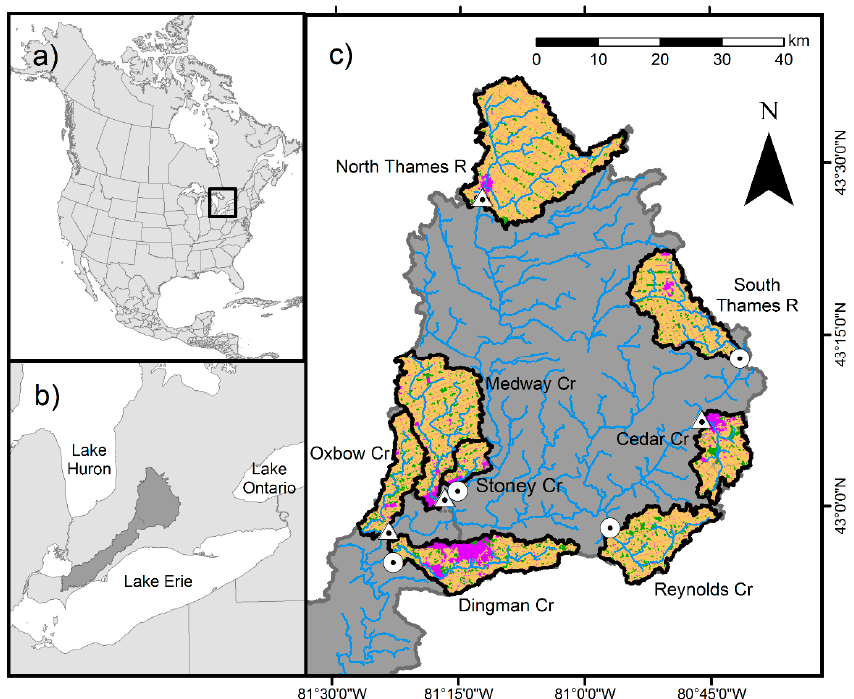
Figure 1. Position of study area in the Great Lakes region of North America ( a ) and location of Thames River watershed in southern Ontario ( b ). Location and land cover (agriculture [orange]; forest [green]; urban [purple]) of eight impacted streams and their associated catchments (black outlines) within the Upper Thames River Basin ( c ). Streams influenced by dams have site points as triangles. Streams without dams have sites represented by circles.